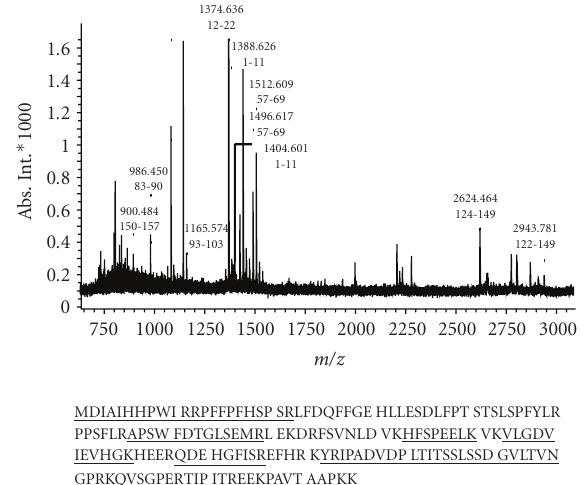
Figure 2: MALDI-TOF peptide mass fingerprints of the tryptic di- gests corresponding to alpha B-crystallin. The matched peptide se- quences are